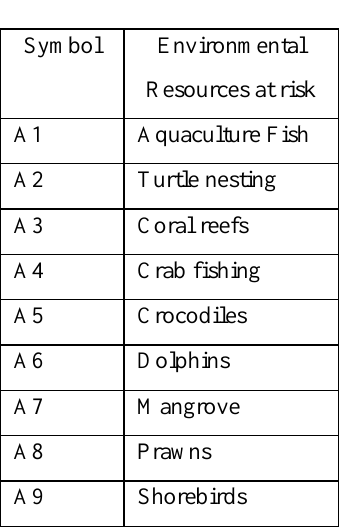
Figure 1: Study Area